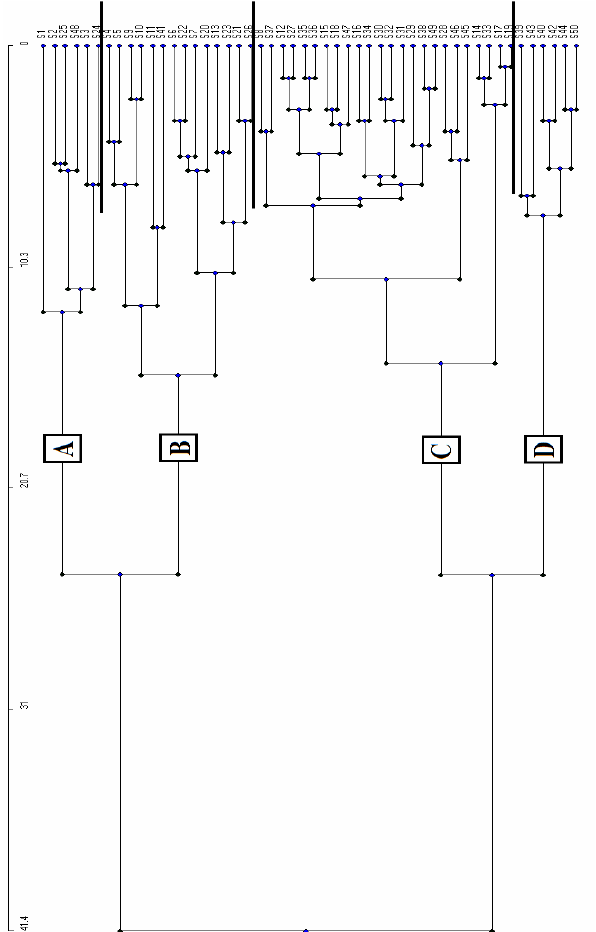
Fig. 4. Dendrogram showing cluster analysis of the studied 50 stands with the 4 vegetation groups (A-D) in Wadi El-Assuity and Wadi